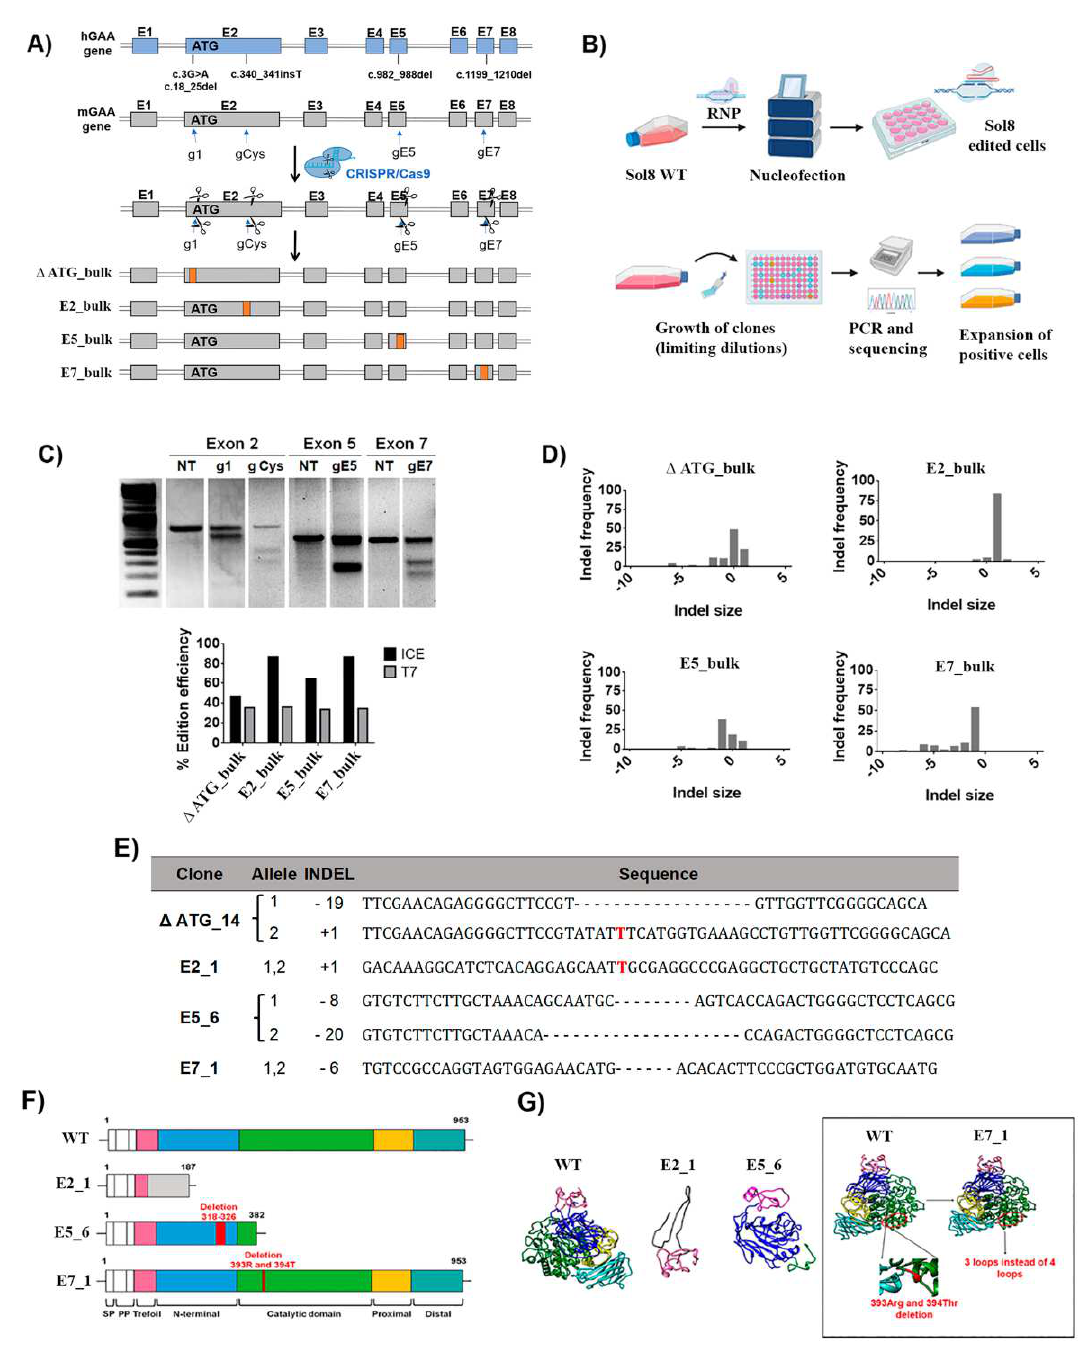
Figure 1. Generation of isogenic murine cellular models in Sol8 cells with severe Pompe mutations. ( A ) Scheme of the strategy designed to generate murine Sol8 cell Pompe models. These cellular models, ∆ ATG, E2, E5 and E7, resemble some mutations present in Pompe patients’ cells, such as c.3G>A and c.18_25del, c.340_341insT, c.982_988del and c.1199_1210del, respectively. These